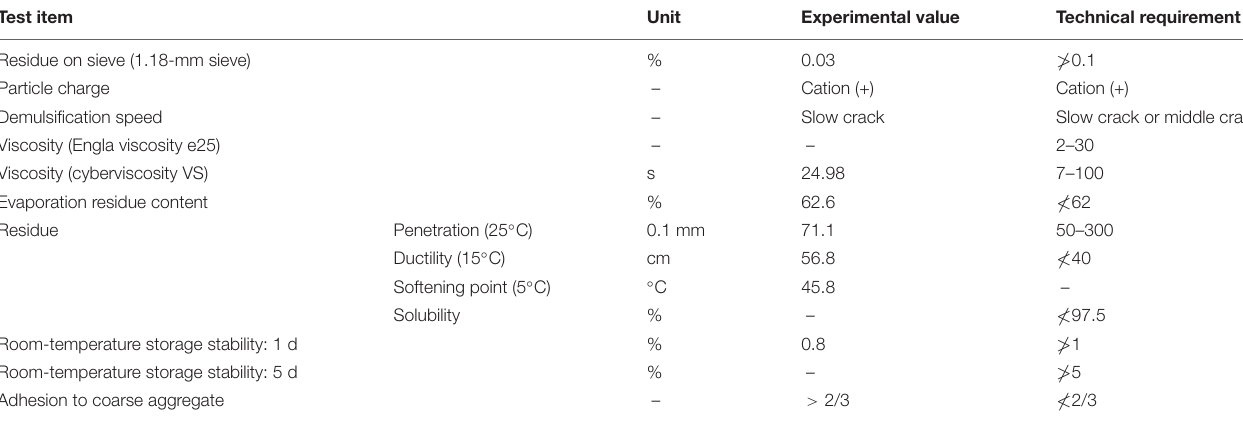
TABLE 1 | Test results of emulsified asphalt